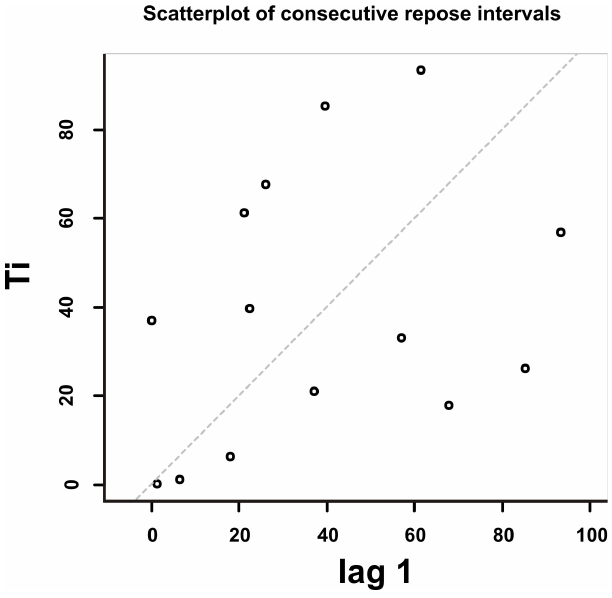
Fig. 2. Scatterplot of consecutive repose intervals for the Canary Islands time series.